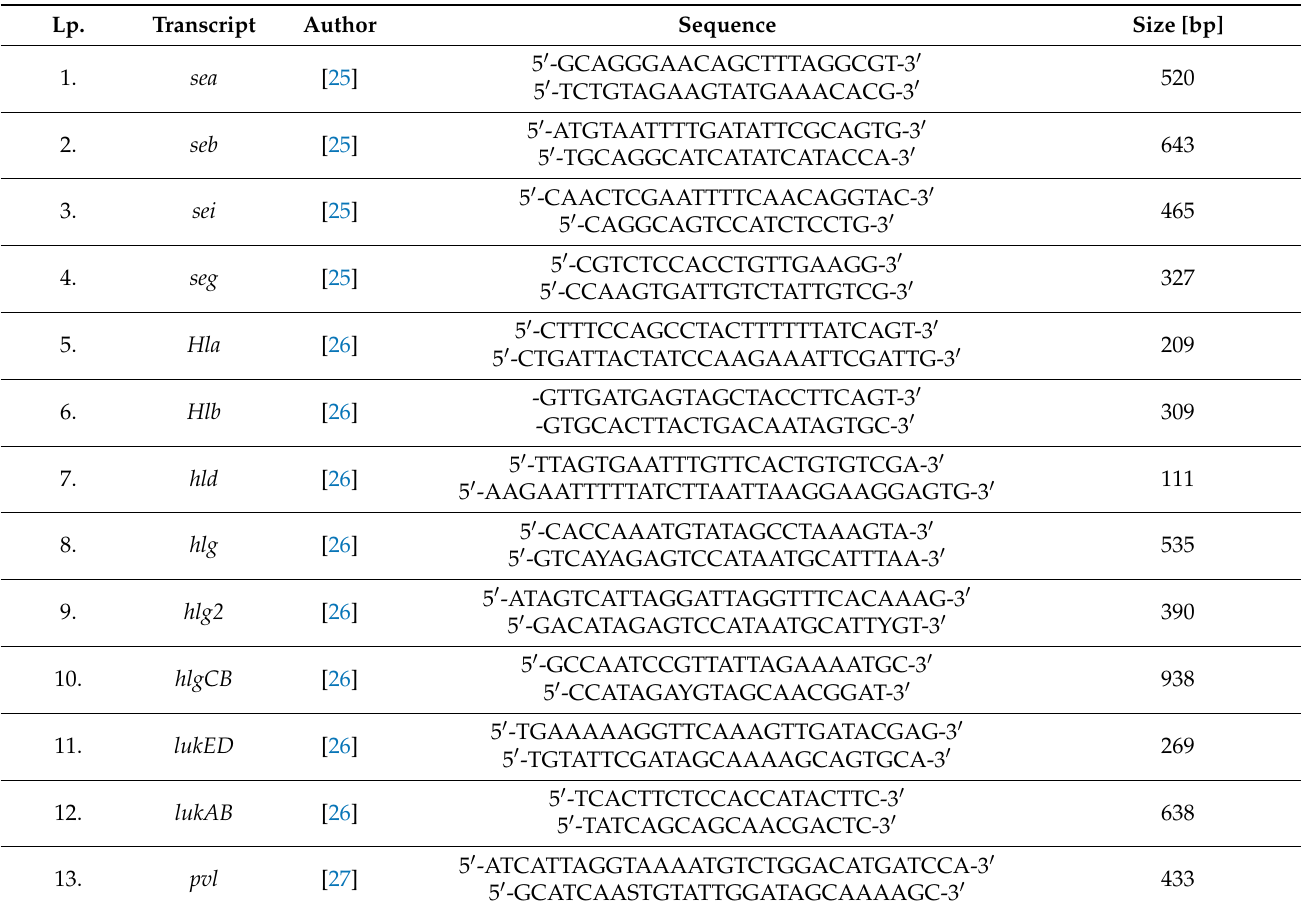
Table 1. Primers used for PCR analysis of genes encoding virulence